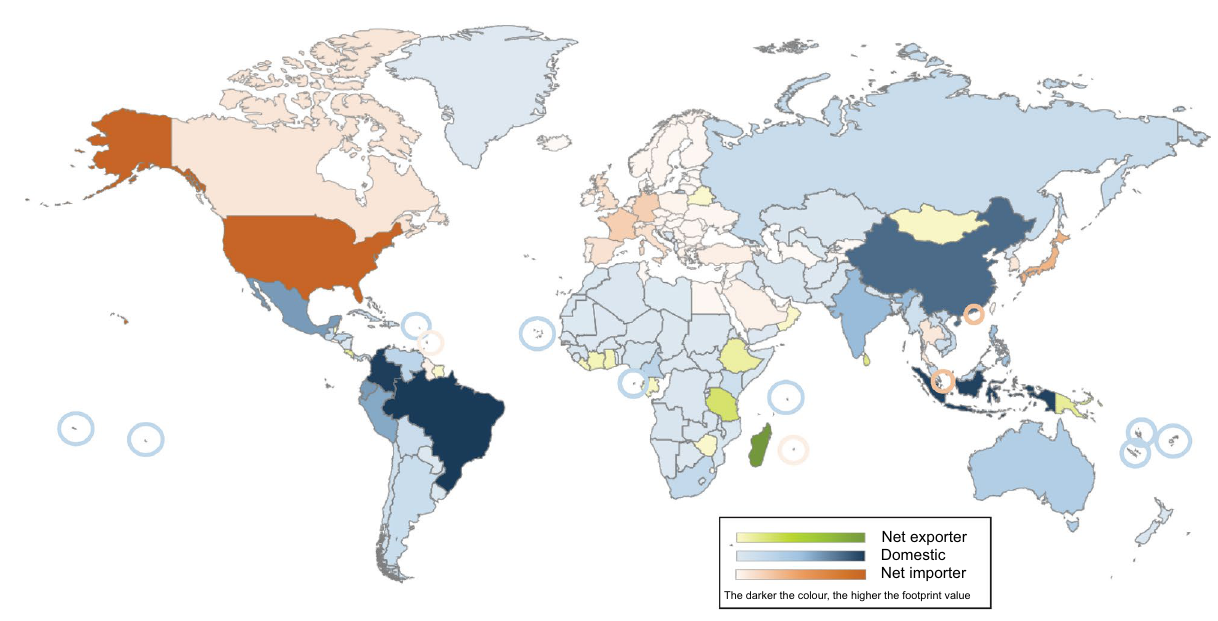
Figure 1. Category of extinction-risk footprint by country. Each of the 188 countries in scope is colour-coded according to which of the imported, exported, or domestic footprints has the highest value in that country. Net importers (orange) primarily drive extinction-risk footprint in other countries, the extinction-risk footprint for net exporters (green) is primarily driven by consumption in other countries, and consumption within the country primarily drives extinction-risk footprint for domestic countries (blue). The darker the colour, the higher the corresponding footprint value (imported extinction-risk footprint for countries colour-coded orange, exported extinction-risk footprint for countries colour-coded green, and domestic extinction-risk footprint for countries colour-coded blue). (Generated using Microsoft PowerPoint https:// www. micro soft. com/ en- us/ micro soft- 365/ power